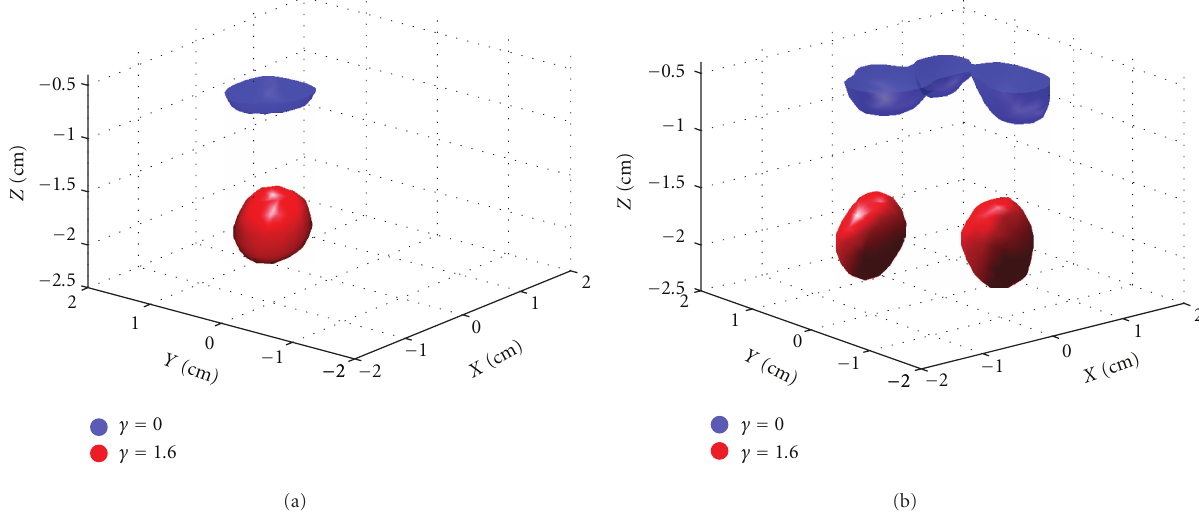
Figure 9: Three dimensional plots of reconstructed images for (a) one inclusion with DCA ( γ = 1 . 6) and without DCA (i.e., γ = 0), and (b) two inclusions with DCA ( γ = 1 . 6) and without DCA ( γ = 0). Voxels with the reconstructed absorption values above 80% of the maximum value are selected as reconstructed